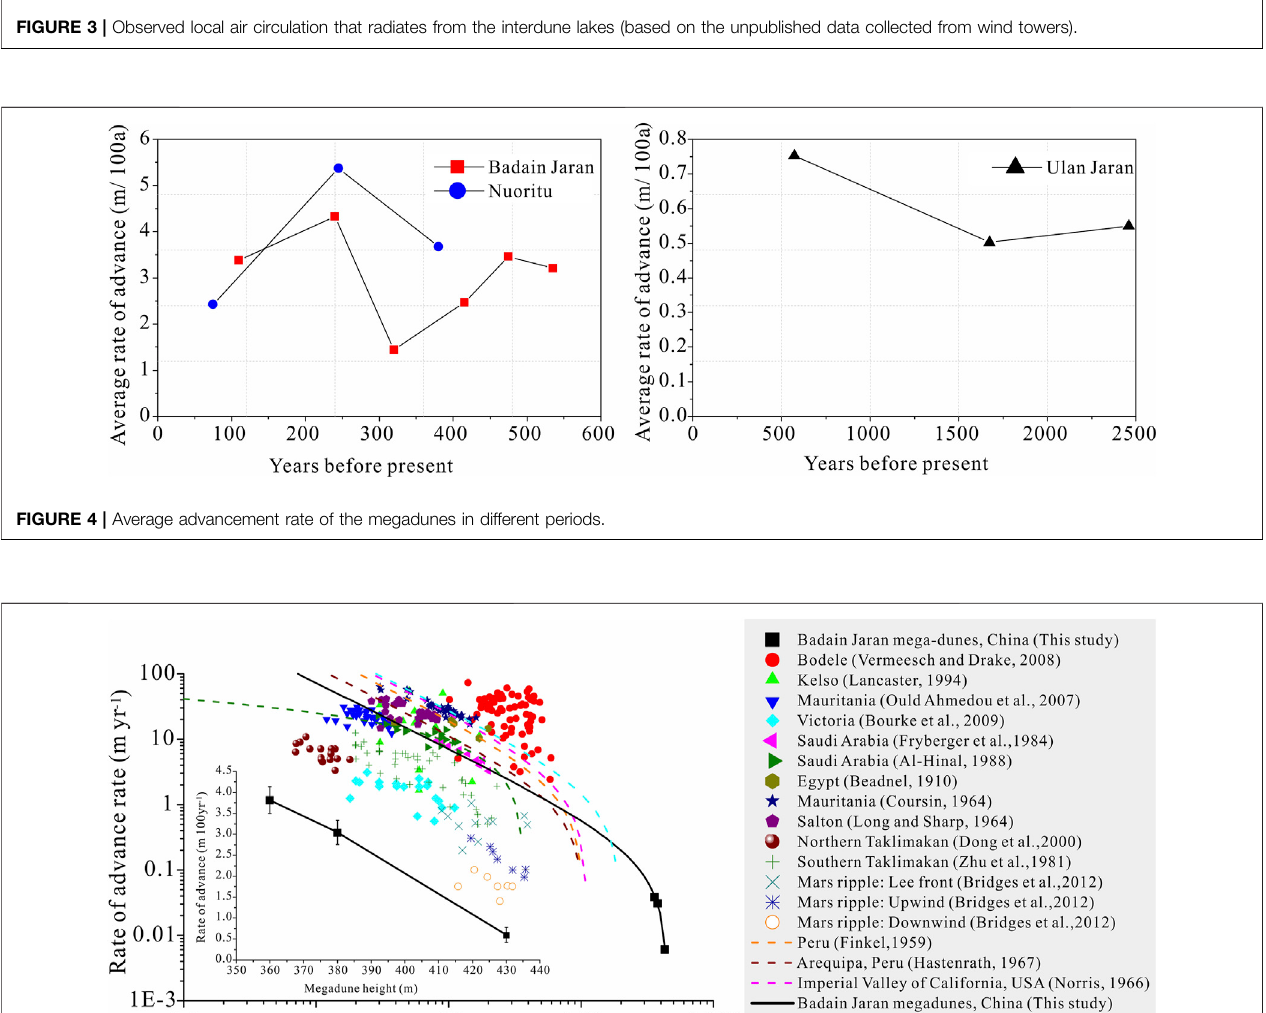
Frontiers in Earth Science |